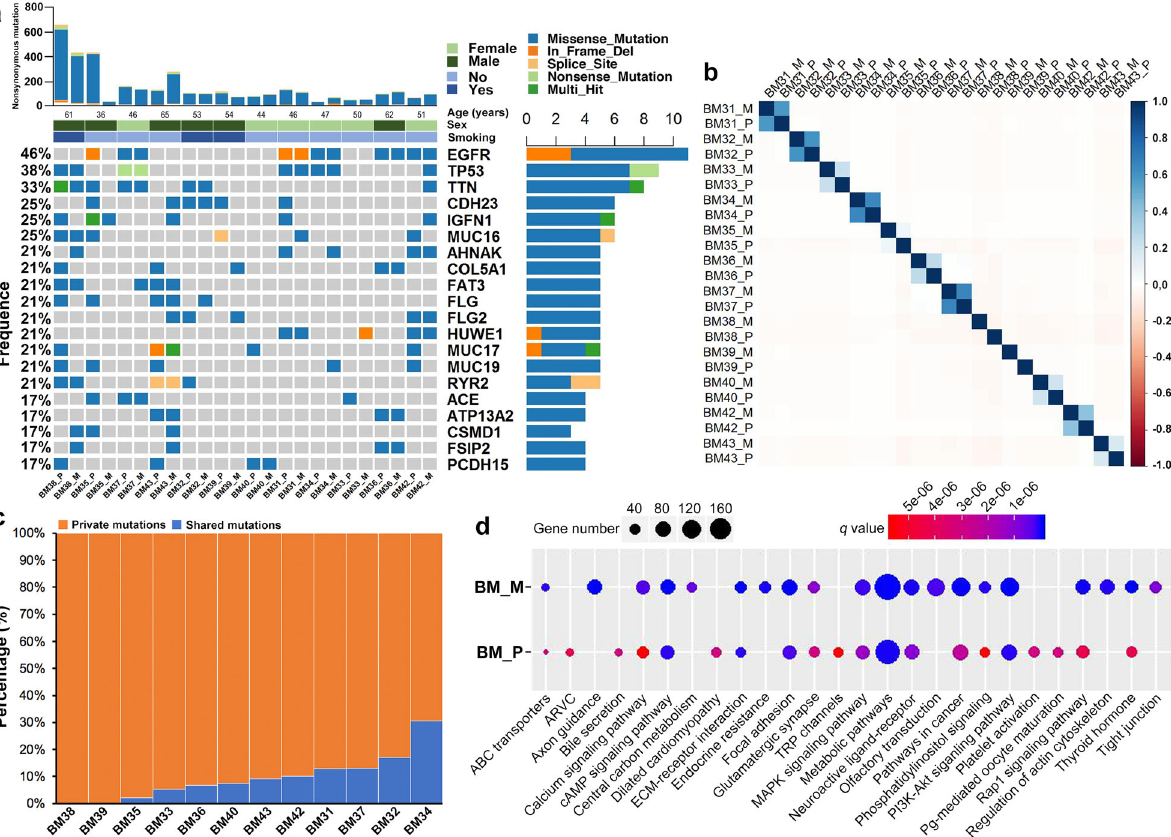
Fig. 2 Overview of mutational landscape. a Identi fi ed mutational landscape of primary lung adenocarcinoma lesions and matched brain metastases (BM). Top panel: the number of somatic mutations in each tumor. Three clinicopathological characteristics (age, sex, and smoking history) are presented below. Left panel: the frequency of listed driver genes. Middle panel: the matrix of mutations in a selection of frequently mutated genes. Columns represent samples. Right panel: the total number of patients harboring mutations in each gene. b Pearson Correlation Coef fi cients of CNVs between primary tumors and BMs in each case. c The percentages of shared (present in both primary and metastatic lesions) or private (present only in primary or metastatic lesions) mutations in each case. d Top 10 enriched pathways via KEGG pathway analysis in primaries and brain metastases. BM_M brain metastatic lesion, BM_P primary